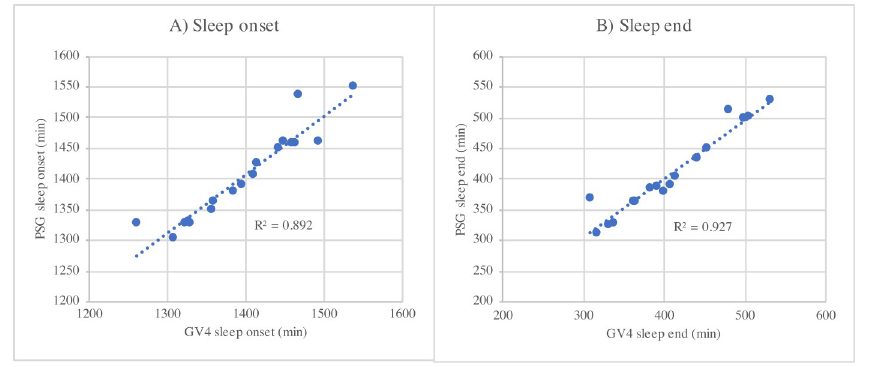
Fig 2. Simple linear regression analyses of sleep onset (A) and sleep end (B). R 2 values are shown.